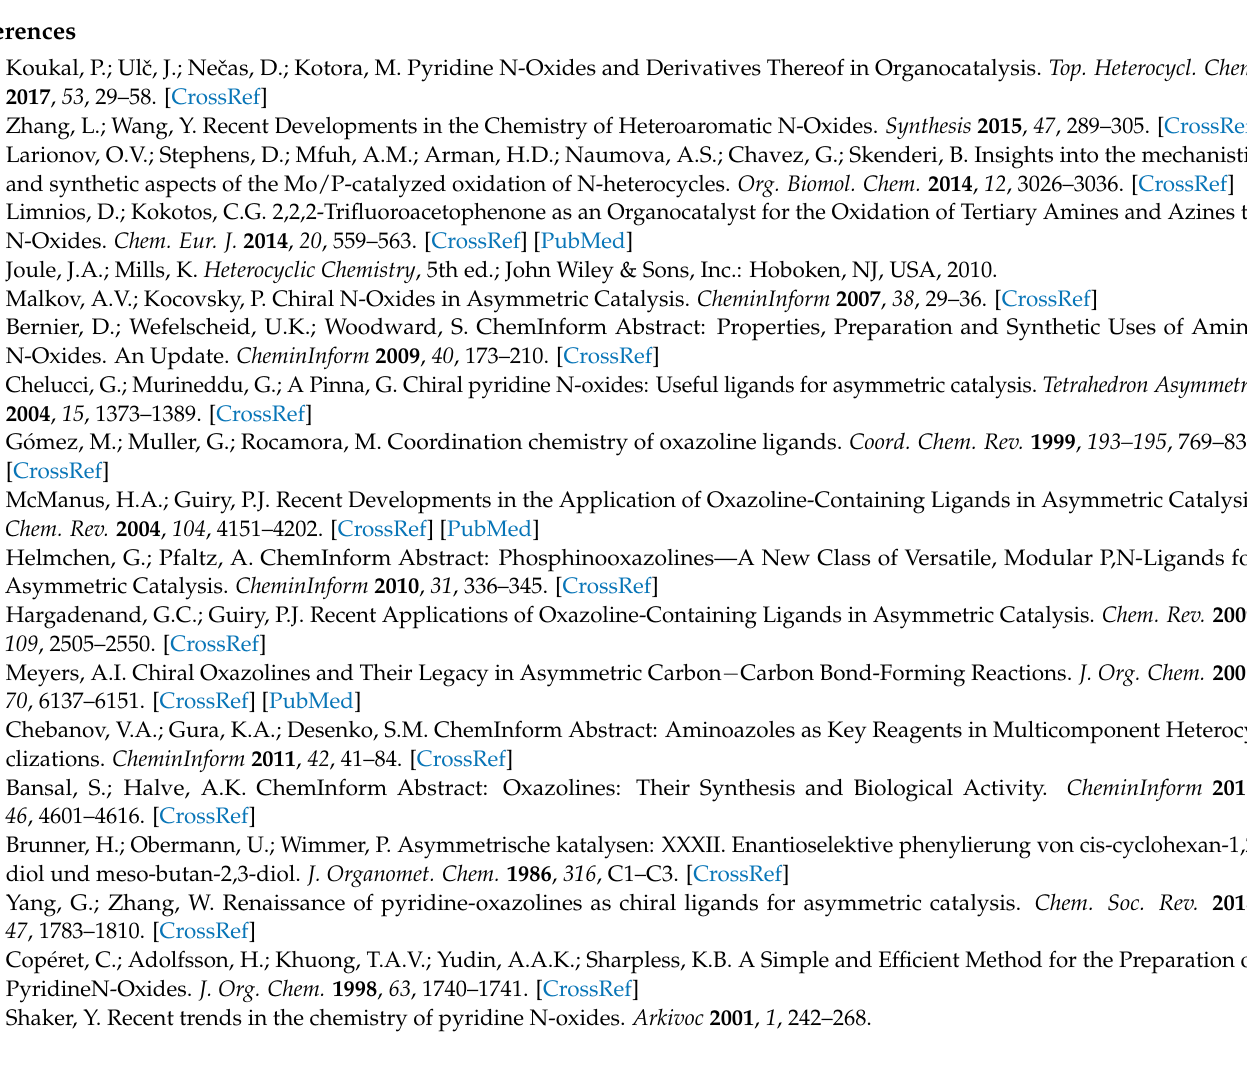
with catalyst 10c , Figure S53. HPLC chromatogram for 1-naphthaldehyde: sample obtained with catalyst 20c , Figure S54. HPLC chromatogram for 2-naphthaldehyde: sample obtained with cat- alyst 4c , Figure S55. HPLC chromatogram for 2-naphthaldehyde: sample obtained with catalyst 10c , Figure S56. HPLC chromatogram for 2-naphthaldehyde: sample obtained with catalyst 20c , Figure S57. HPLC chromatogram for racemate, Figure S58. HPLC chromatogram for sample obtained with catalyst 4a , Figure S59. HPLC chromatogram for sample obtained with catalyst 4c , Figure S60. HPLC chromatogram for sample obtained with catalyst 4e , Figure S61. HPLC chromatogram for sample obtained with catalyst 22